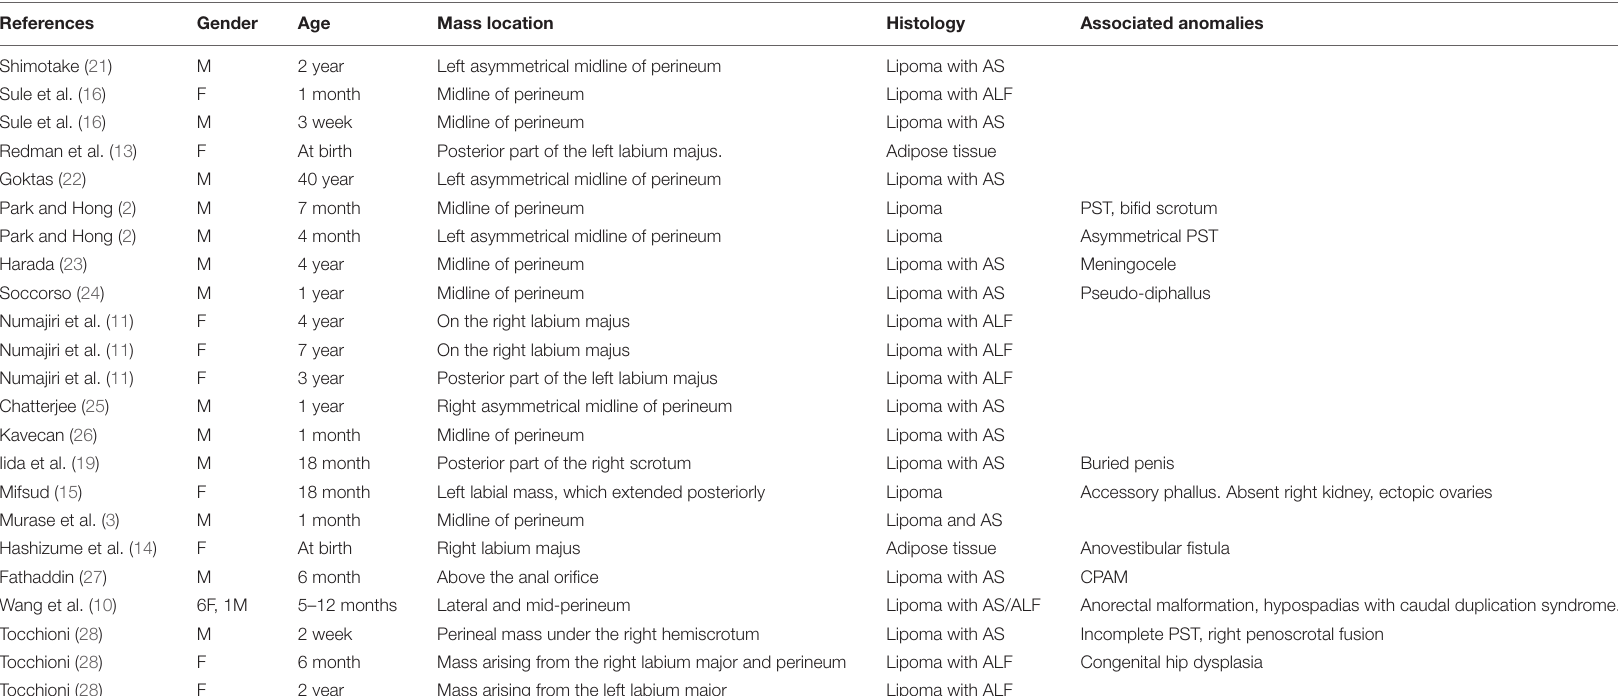
TABLE 1 | Characteristics of the patients with perineal lipoma associated with accessory scrotum or accessory labioscrotal fold reported in the literature from 1990 to 2022 including our three